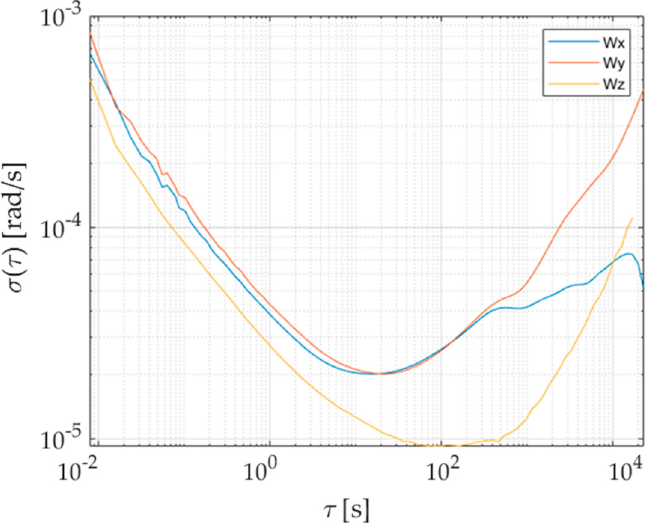
Figure 8. Allan deviation of gyroscopes along the three sensing axes of the prototype.